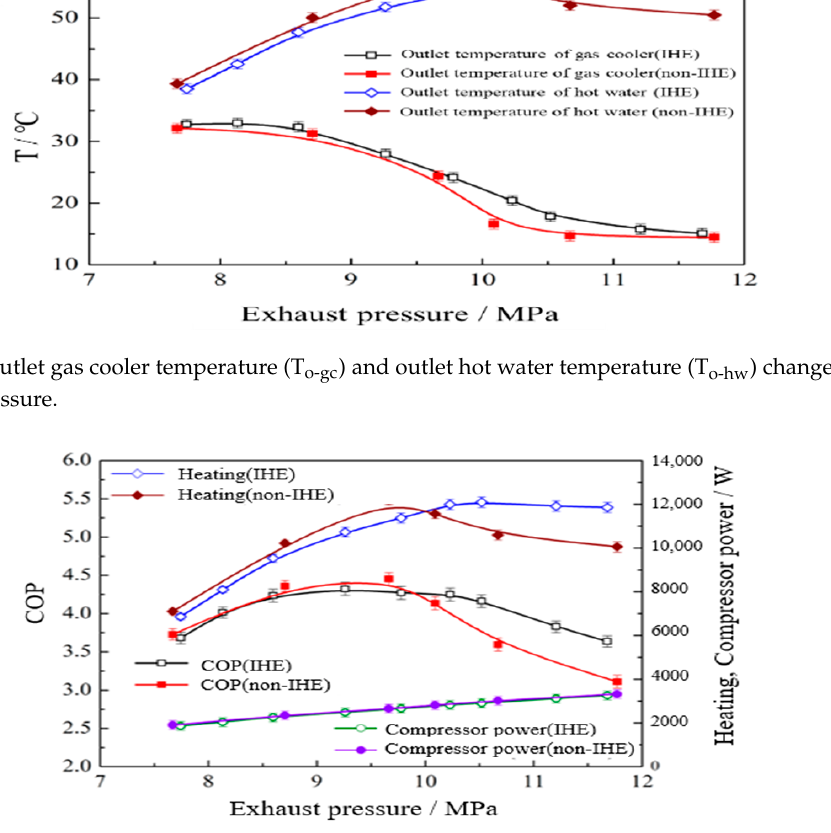
Figure 4. Comparison of heating, compressor power and coefficient of performance (COP).